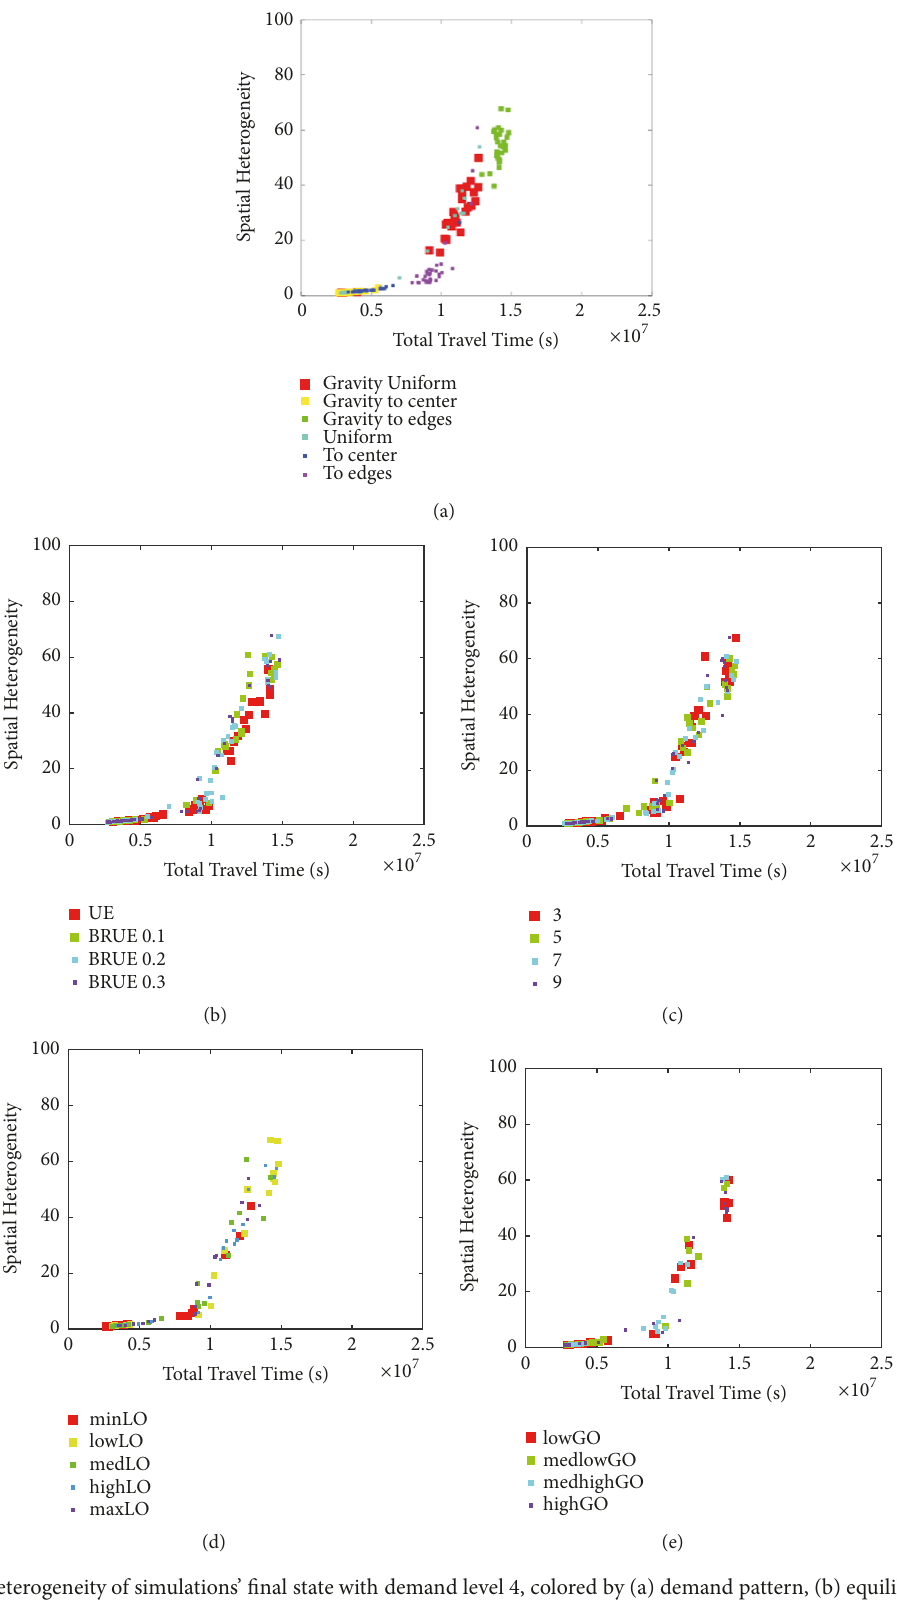
Figure 9: Spatial heterogeneity of simulations’ final state with demand level 4, colored by (a) demand pattern, (b) equilibrium criterion, (c) number of paths per OD, (d) global overlapping level, or (e) local overlapping